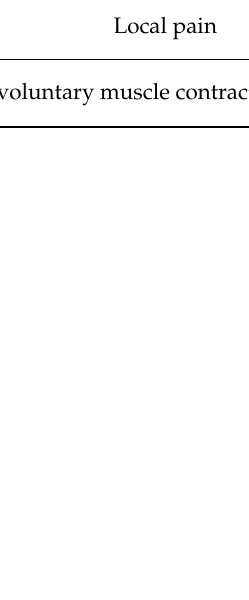
Table 3. Secondary adverse events (new symptoms since the last exam) in the ten Sm14-vaccinated women. Day of Exam New Symptoms since Previous Exam (Duration) Relationship to the Sm14